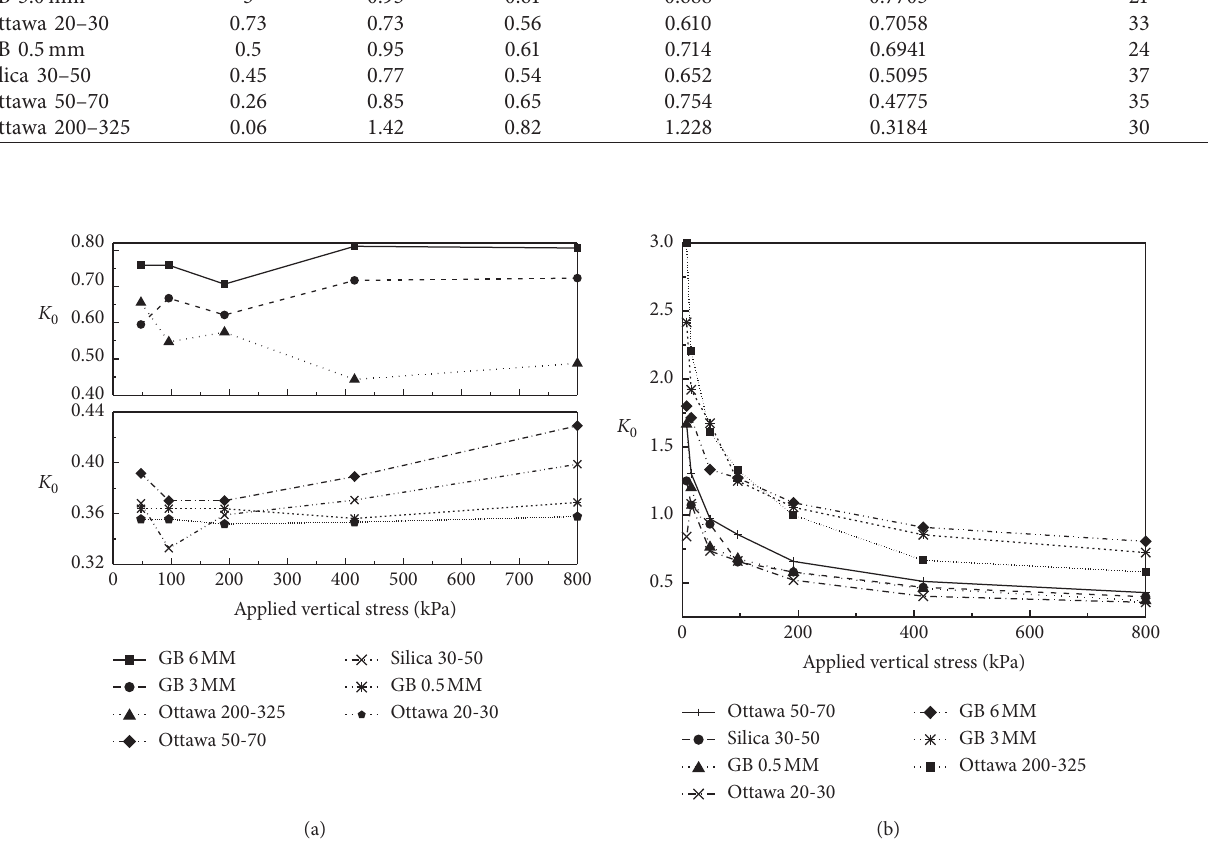
Figure 3: K 0 of different materials during (a) loading and (b)